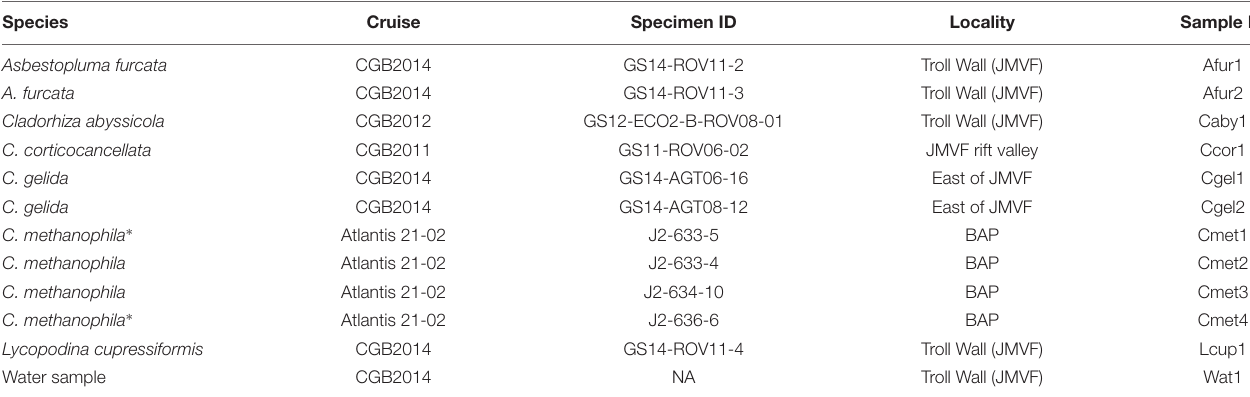
TABLE 1 | List of samples analyzed in the current study.